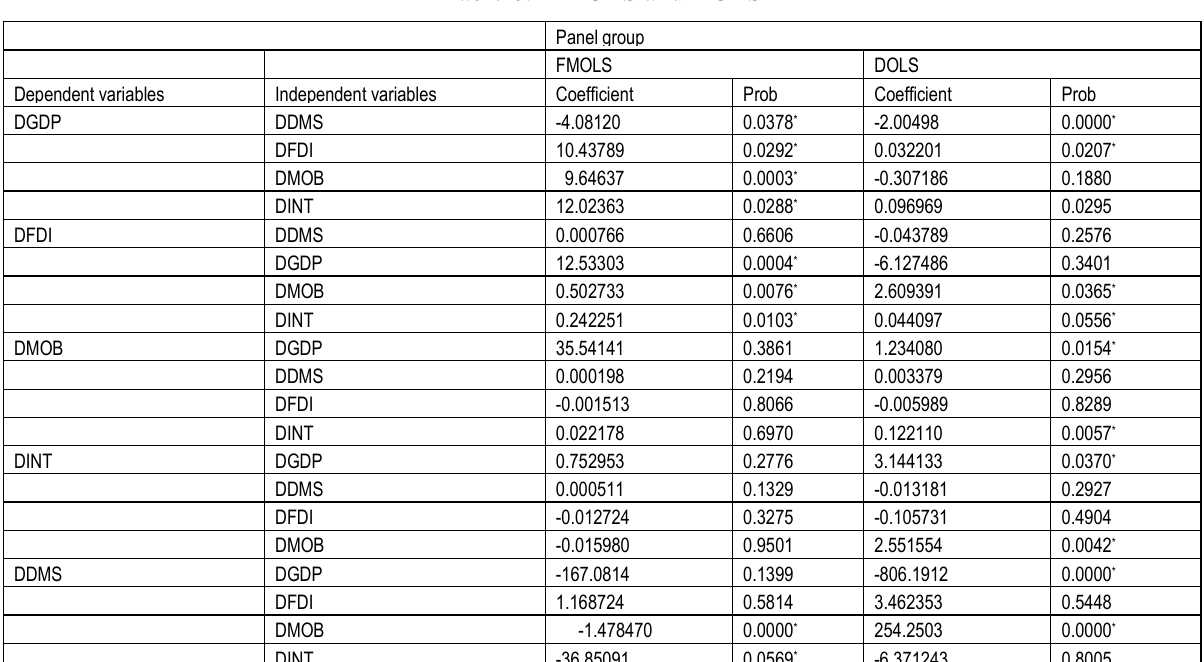
Table 6. FMOLS and